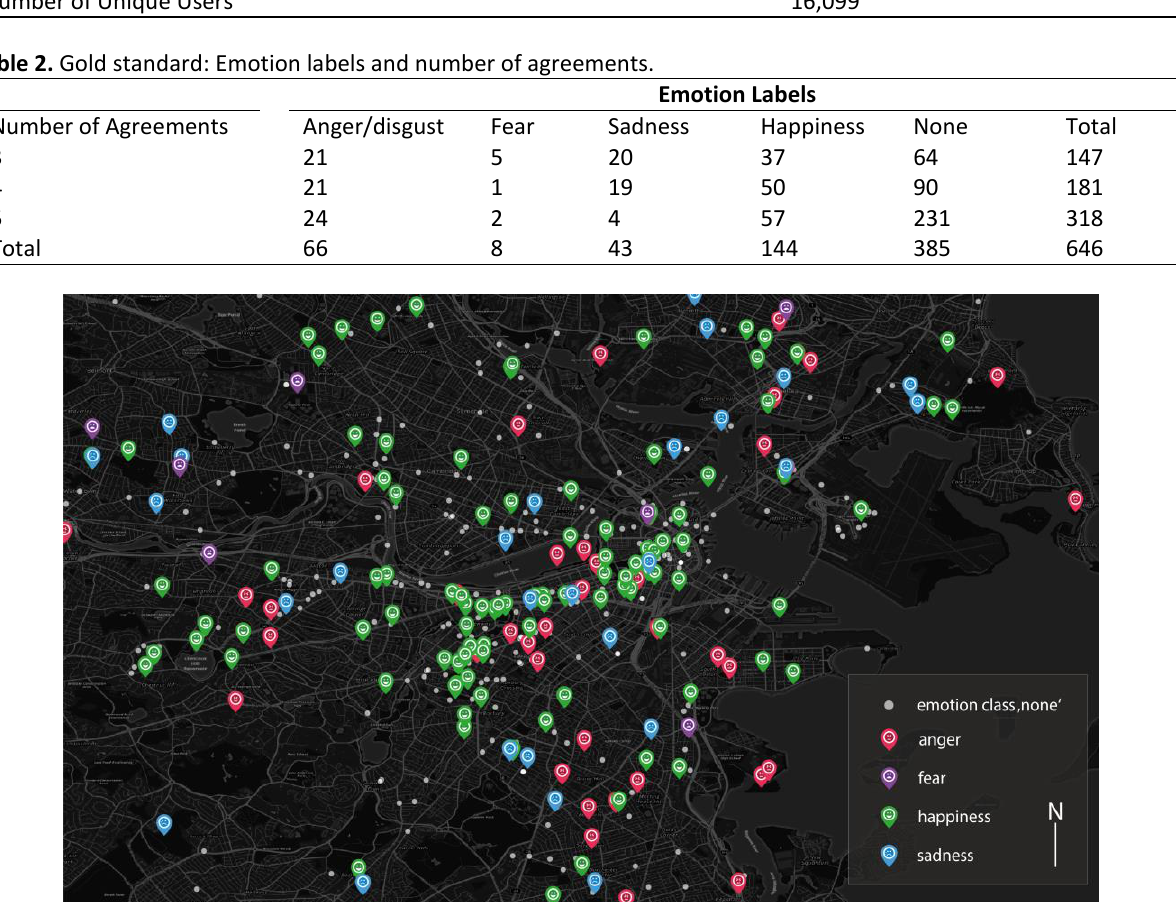
Figure 2. Spatial distribution of the gold